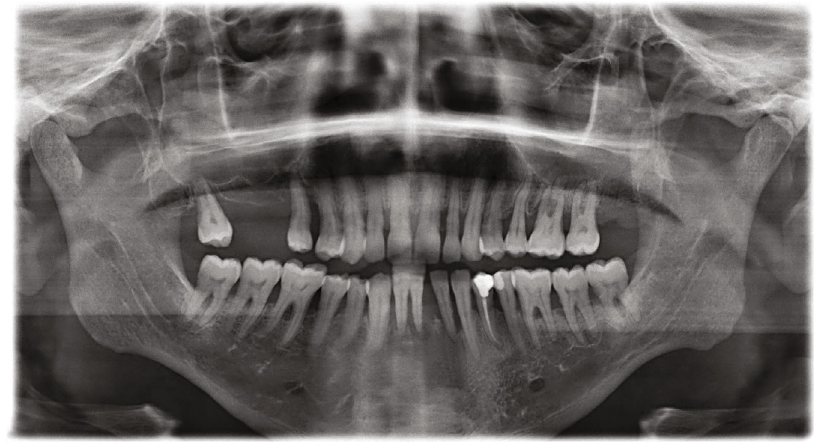
Figure 3: Orthopantomogram showing multiple missing teeth and endodontic treatment of tooth #34.